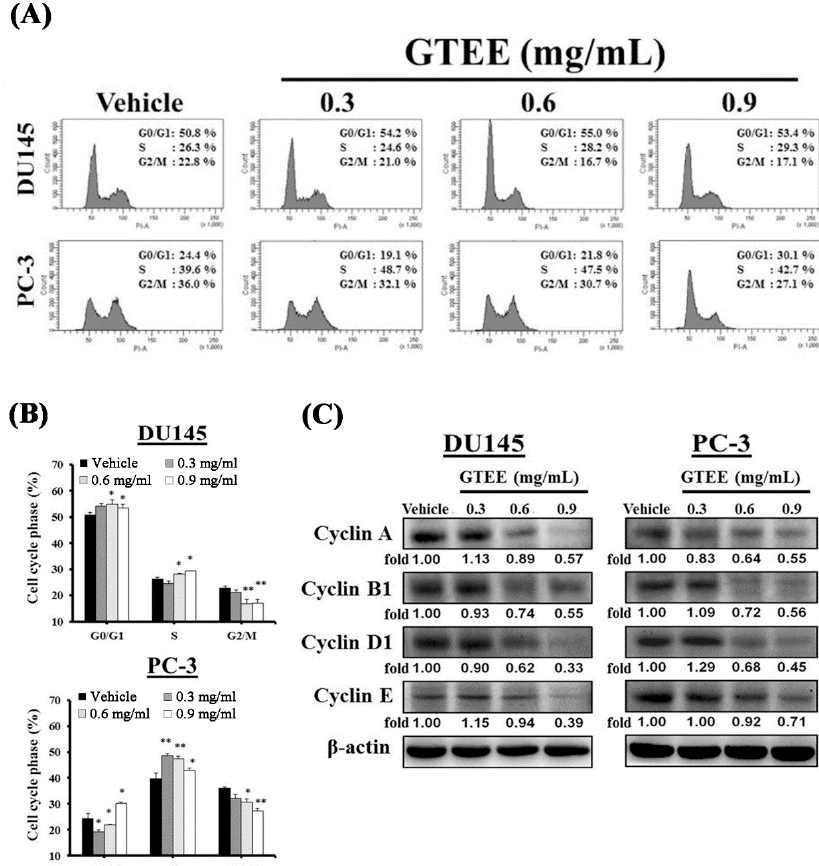
Figure 2. GTEE induces cell cycle arrest and reduces expression of cell cycle-related proteins in mPCa cells. ( A ) DU145 and PC-3 cells were treated with vehicle or GTEE (0.3, 0.6 or 0.9 mg / mL) for 8 h. The cell cycle distribution was measured by flow cytometer assays. ( B ) The quantification of the results from ( A ). Data represent the mean ± SD of three separate experiments. * P < 0.05, ** P < 0.01. ( C ) DU145 and PC-3 cells were treated with vehicle or GTEE (0.3, 0.6 or 0.9 mg/mL) for 8 h. The total proteins were harvested and expression of cell cycle-related proteins, including cyclin A, B1, D1 and E, were determined by Western blot analysis. β -actin was used as a loading control. The level (fold) of protein expression with the vehicle treatment was assigned as 1.00.